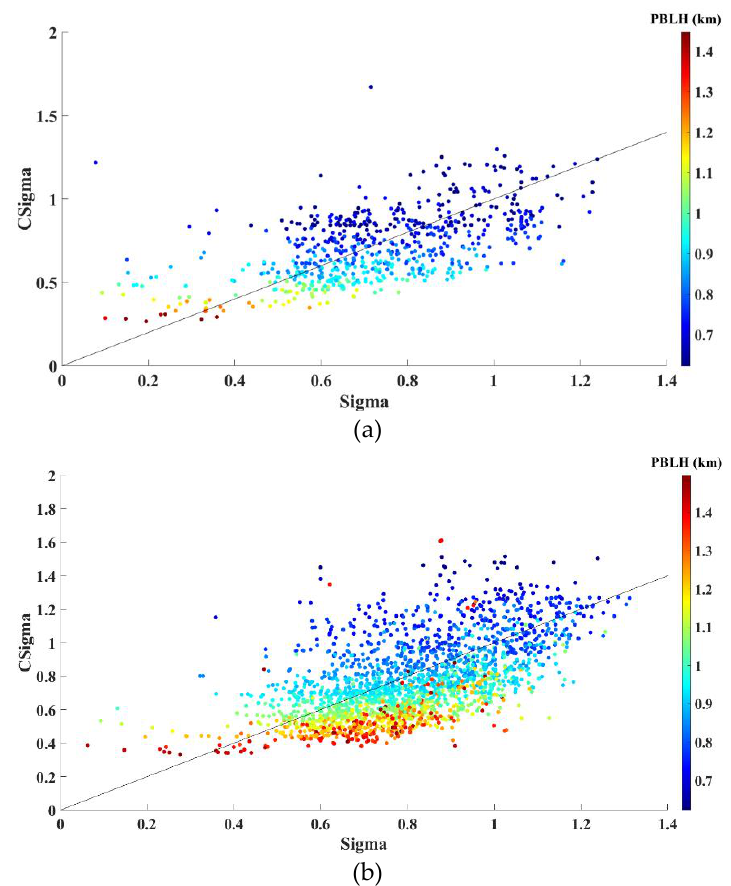
Figure 7. Comparison of the calculated Sigma (CSigma) values with the reference Sigma (manually fitted) values for the cases in which ( a ) Δh < 0.35 km and ( b ) Δh ≥ 0.35 km, respectively.